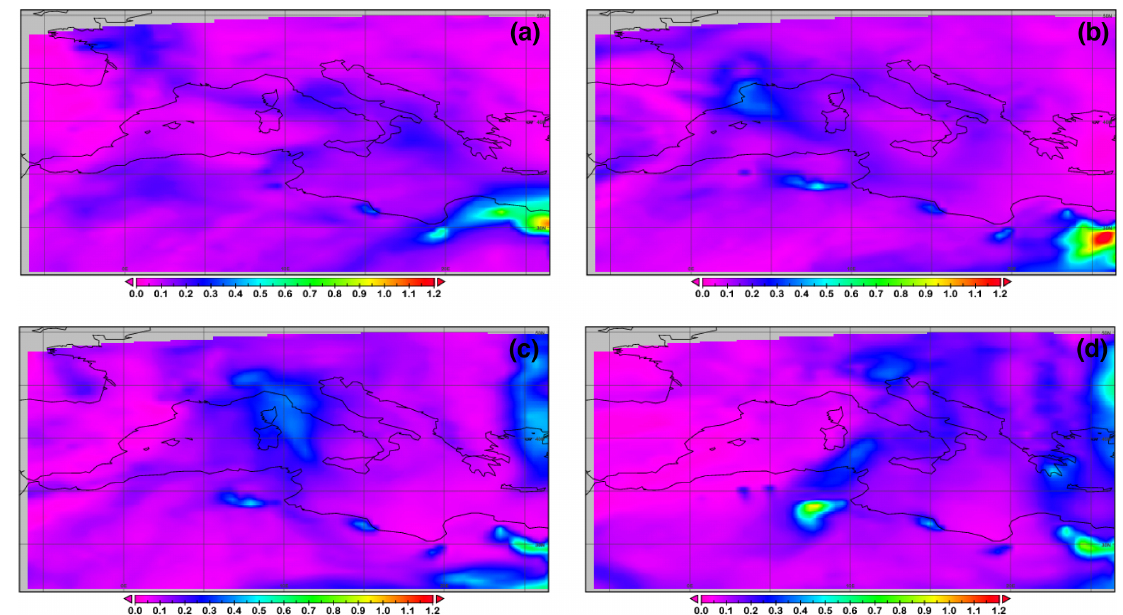
Figure A2. As in Fig. 5 (right panel) except that the S11 rather than the S01 configuration is used.